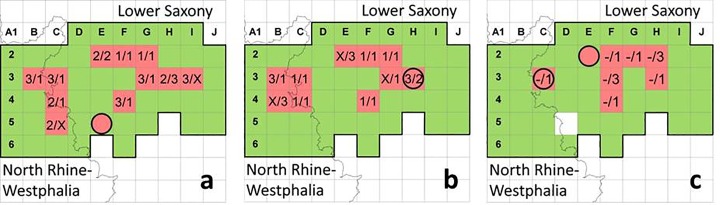
Area of North Germany in the federal states of North Rhine-Westphalia and Lower Saxony checked for Ae. j. japonicus in 2013 (a), 2014 (b) and 2015 (c). Red squares: grid cells positive, green squares: grid cells negative by cemetery inspection, circles: grid cells with Ae. j. japonicus submissions to the ‘Mueckenatlas’; figures in the grid cells denote findings in May/August with ‘1’, ‘2’, ‘3’ representing the number of cemeteries inspected until Ae. j. japonicus was found, ‘X’ representing three negative cemeteries in case only one of the two collection seasons was positive, and ‘-‘ meaning not sampled. The area framed in bold marks the reference area used for statistical analysis.